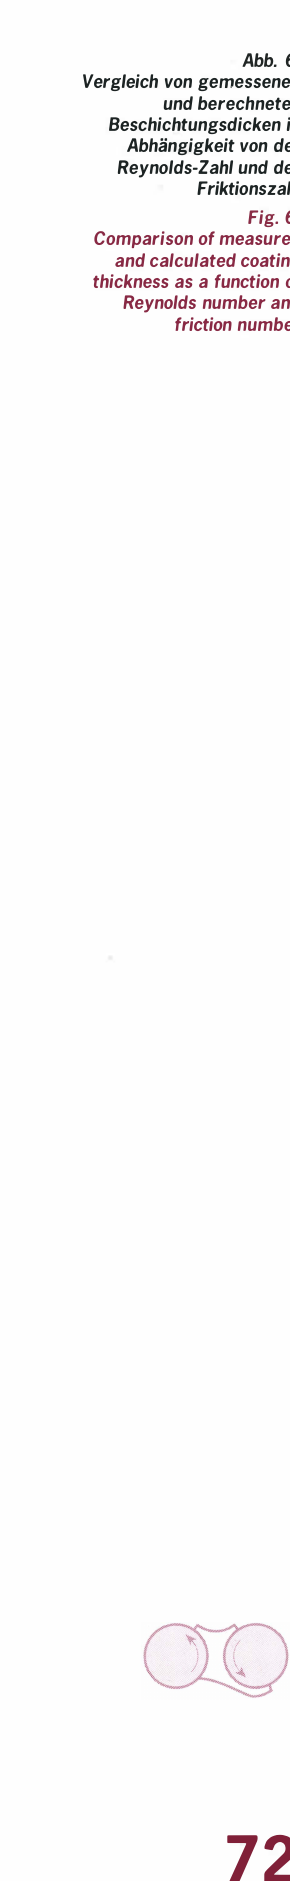
The temperature profile in the roll